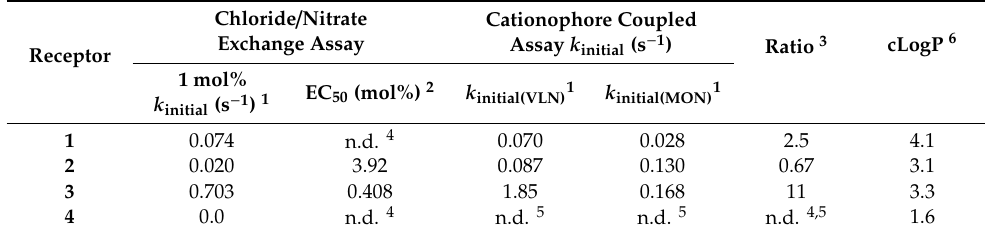
Receptor Table 2. The initial transport rates of electrogenic and electroneutral transport of receptors 1 – 4 .